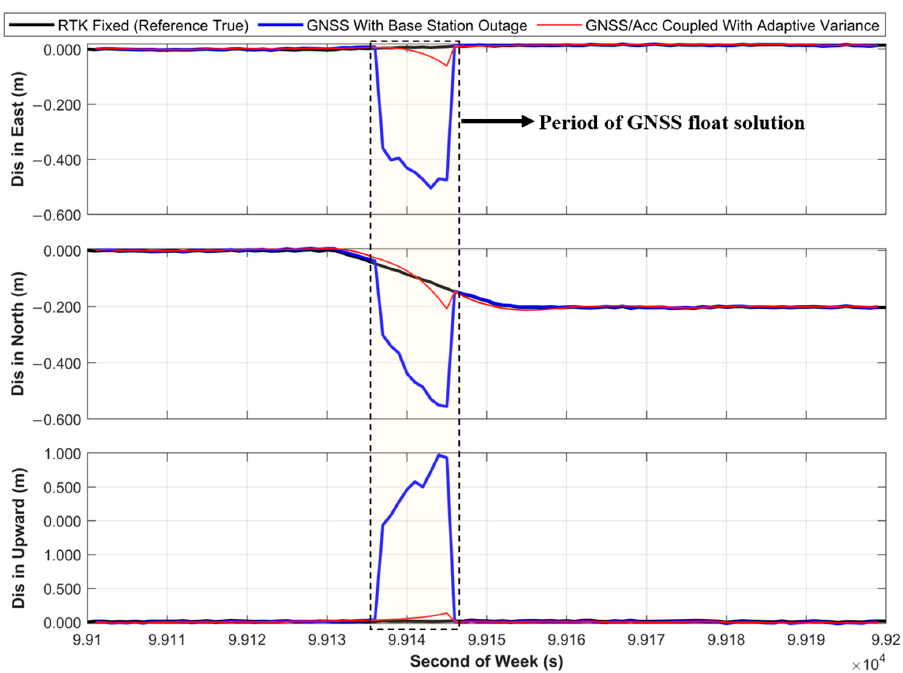
Figure 9. Coupled displacement results of the simulated landslide sliding period in Scene 2.1.